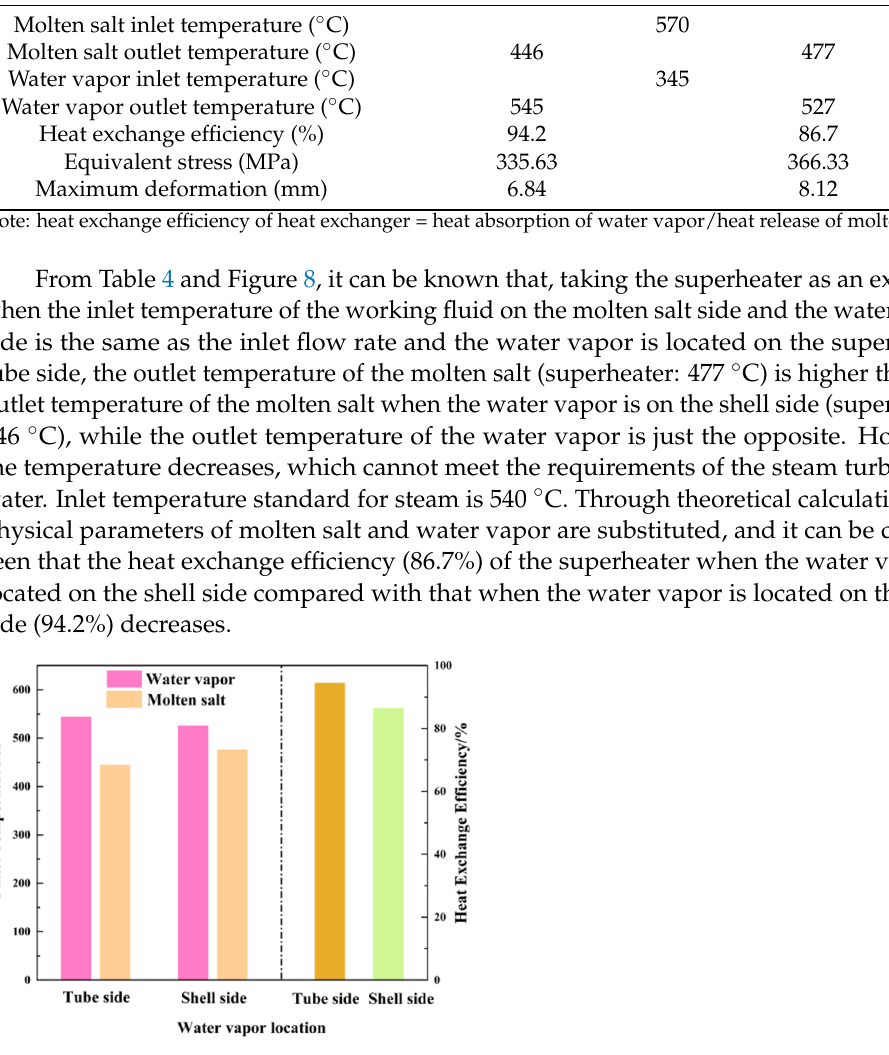
Figure 8. Outlet temperature and heat exchange efficiency when the heat transfer working medium in the superheater is located at different positions.